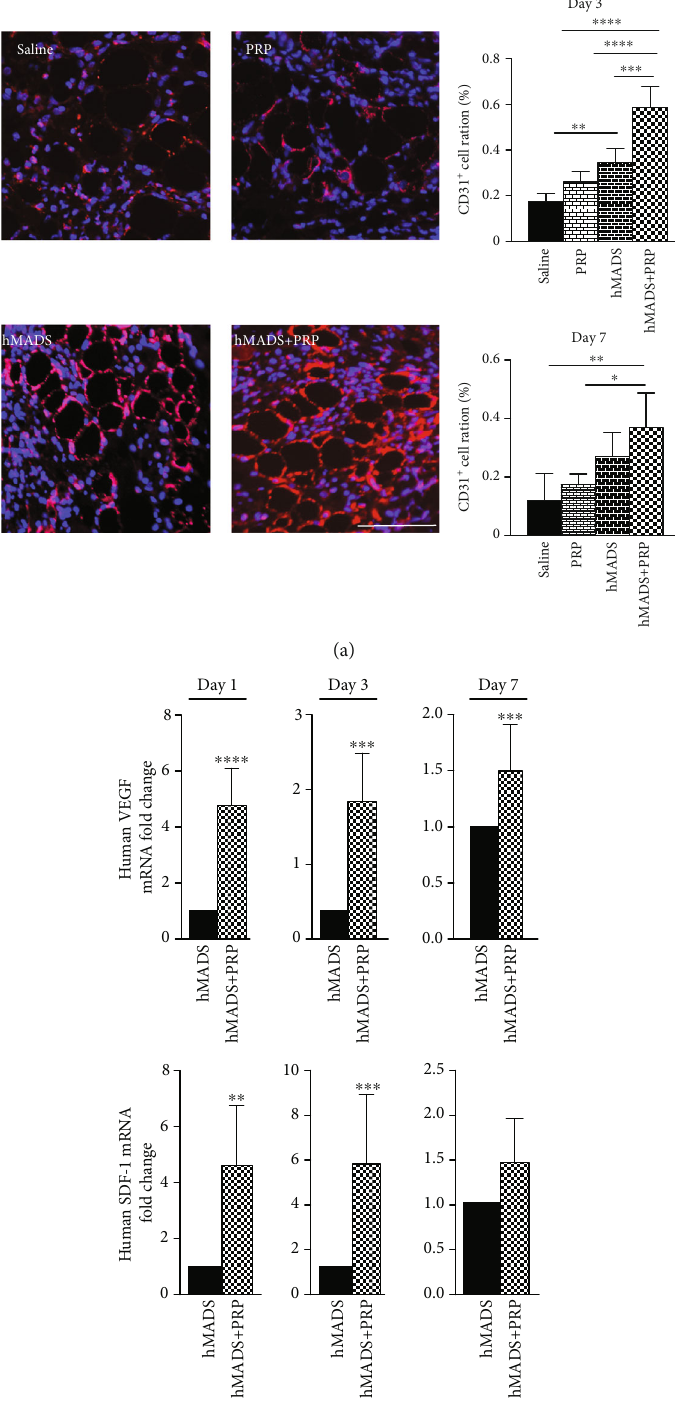
Figure 2: PRP treatment stimulates the proangiogenic properties of engrafted human MSC (hMADS cells) into mouse wounds. (a) Left panel: representative CD31 immunostaining of mouse wounds (red signal) at day 3 following treatment with saline solution, PRP, hMADS cells, or hMADS cells in combination with PRP, respectively. Nuclei were counterstained with Hoechst 33342 (blue signal). Scale bar, 50 μ m. Right panels: quanti fi cation of CD31-positive cells in mouse wounds at day 3 and day 7 following treatment with saline solution, PRP, hMADS cells, or hMADS cells in combination with PRP, respectively. (b) Relative human VEGF and human SDF-1 transcriptional expression in mouse wounds corresponding to the expression of hMADS cells engrafted in combination with PRP by reference to the expression in hMADS cells engrafted alone, at day 1, day 3, and day 7 postinjury. Results represent the mean ± SD obtained from at least n = 5 mice per group. ∗ p < 0 : 05 , ∗∗ p < 0 : 01 , ∗∗∗ p < 0 : 001 , ∗∗∗∗ p < 0 : 0001